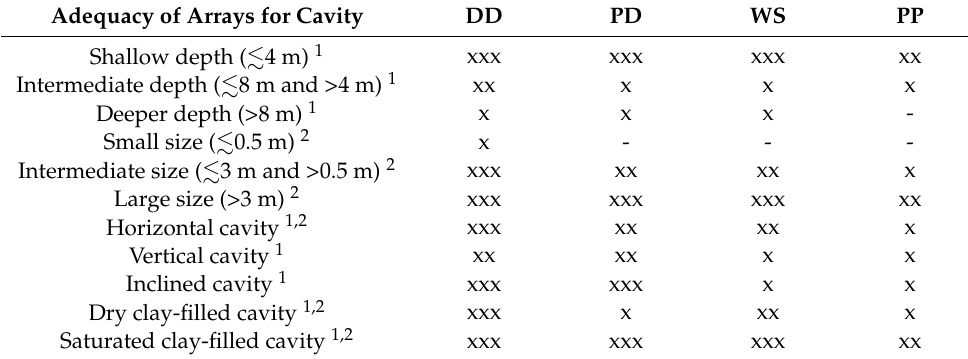
Figure 29. Pole-pole (PP) array sensitivity to resistivity perturbations. The inverted model for: ( a ) ±20% perturbation, ( b ) ±40% perturbation, ( c ) ±60% perturbation, ( d ) ±80% perturbation. Table 1. Adequacy of the resistivity imaging types for cavity study: highly effective = xxx, moderately effective = xx, and less effective =